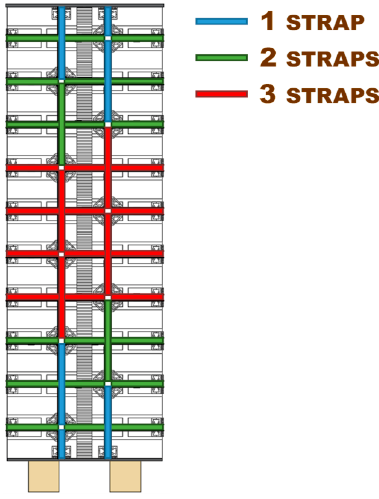
Figure 47. Scheme of strapping for Specimen W4.